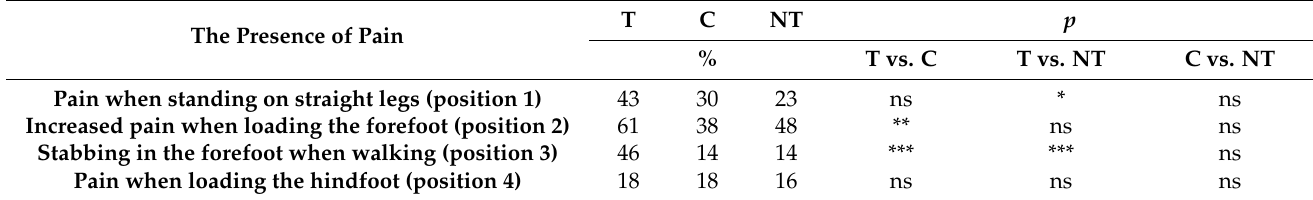
Table 6. Percentage of feet with pain reported in group T—treatment (N = 76); C—control (N =